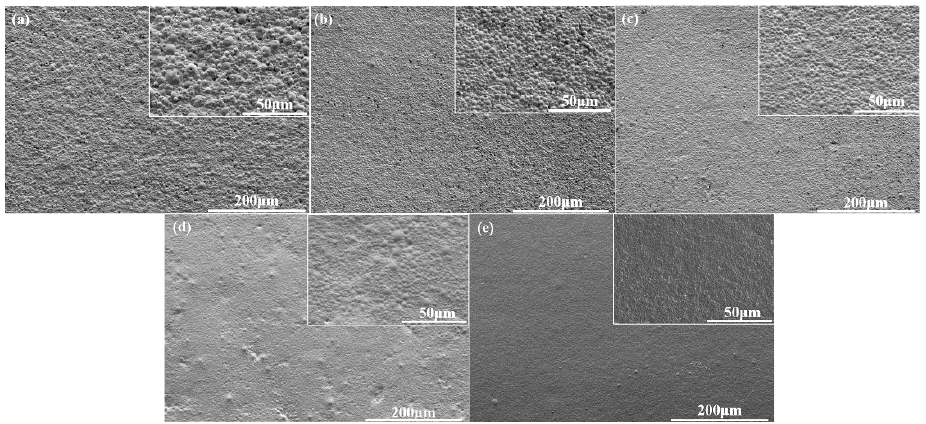
Figure 11. SEM micrographs of WPU-P films with different PCLD contents: ( a ) 12%; ( b ) 15%; ( c ) 18%; ( d ) 21%; ( e ) 24%.